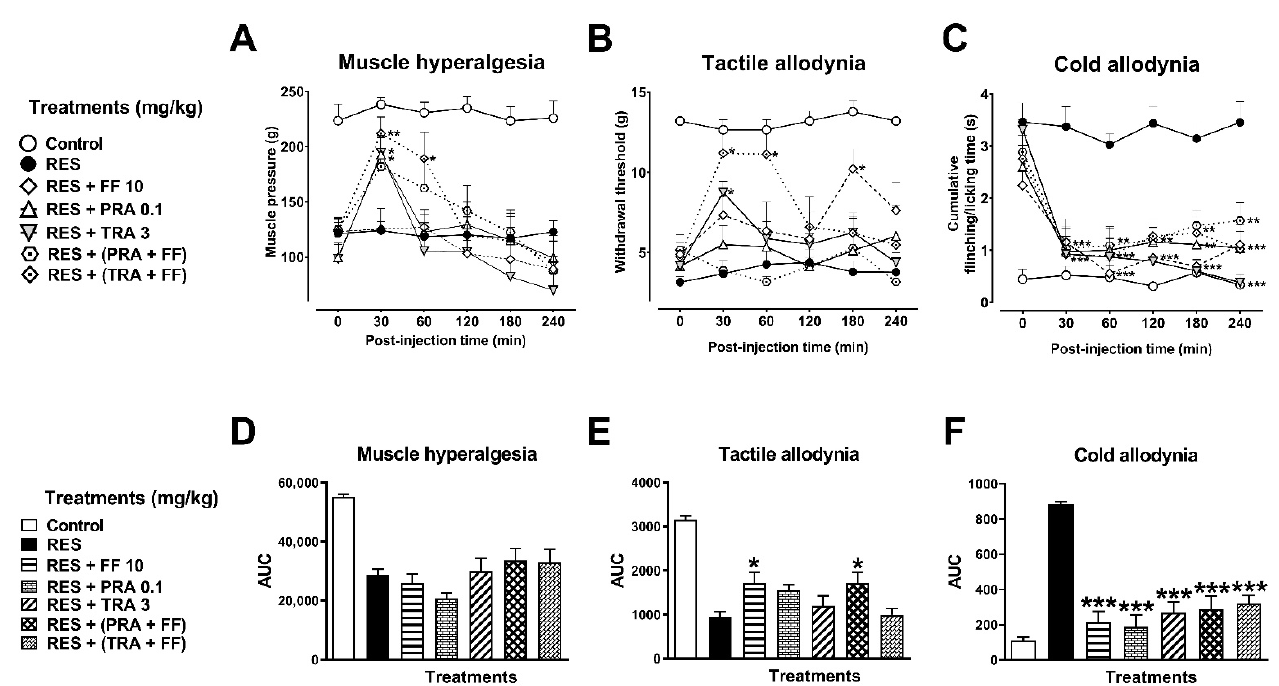
Figure 8. Antihyperalgesic and antiallodynic effects of the flavonoid fraction of Tilia (FF) in combination with pramipexole (PRA) or tramadol (TRA) on the reserpine (RES)-induced nociceptive threshold. Time-course curves of the threshold to muscle pressure, shown as the force in grams supported in the right gastrocnemius muscle ( A ), the tactile response, shown as the force in grams supported on the plantar surface of the right hind limb ( B ), and cold allodynia, shown as the cumulative response time to cold stimulus (acetone) on the dorsal surface of the right hind limb for 1 min ( C ). Area under the curves of the muscle pressure threshold ( D ), tactile response ( E ), and cold allodynia ( F ). One-way or two-way ANOVA followed by Tukey´s test, * p < 0.05, ** p < 0.01, *** p < 0.001 vs. RES group.